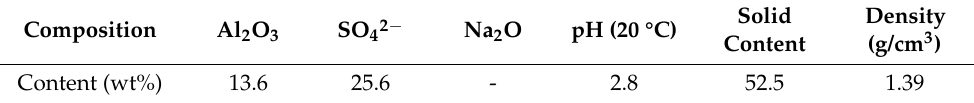
Table 3. The basic composition of the aluminum sulfate-based alkali-free accelerator (liquid).